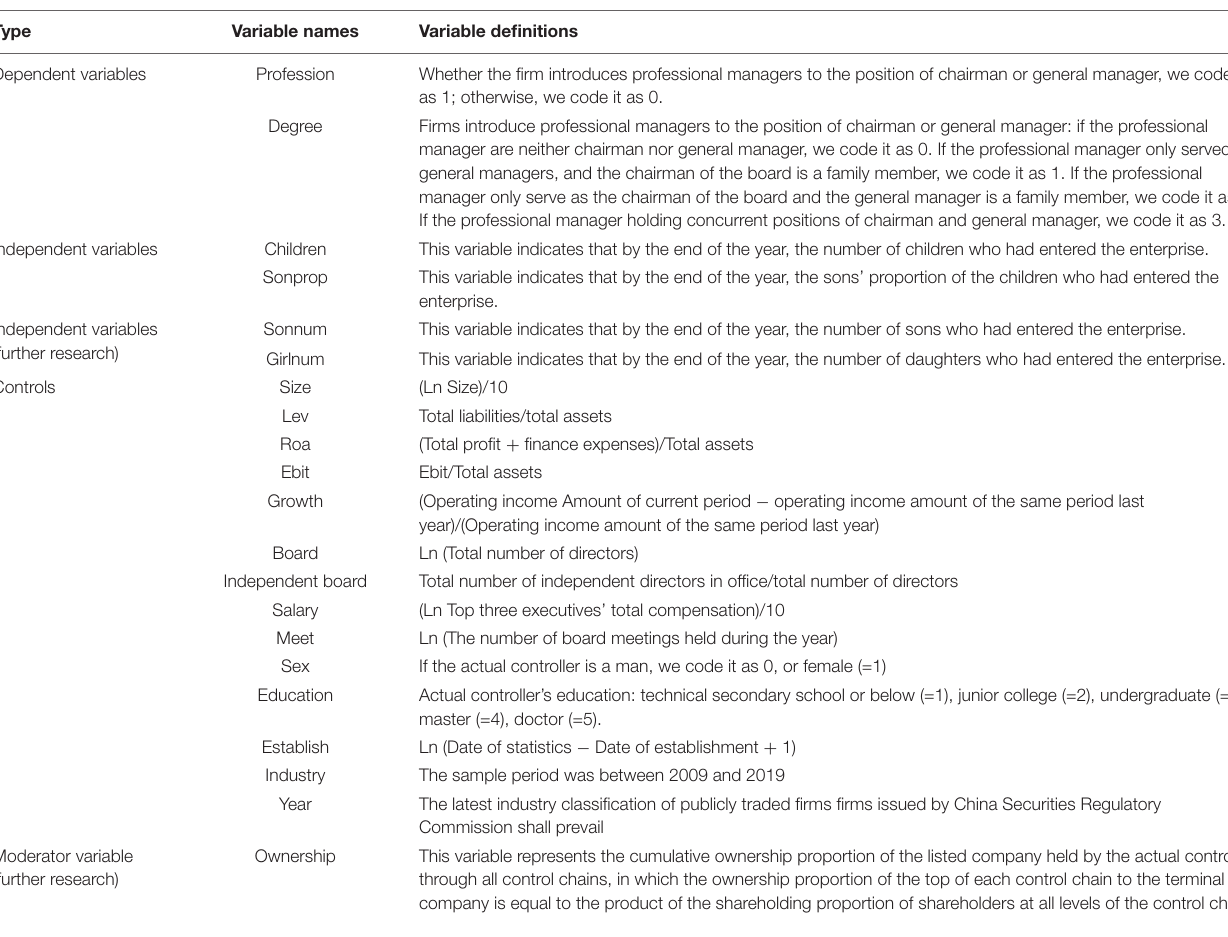
FIGURE 1 | Conceptual model. TABLE 1 | Variable